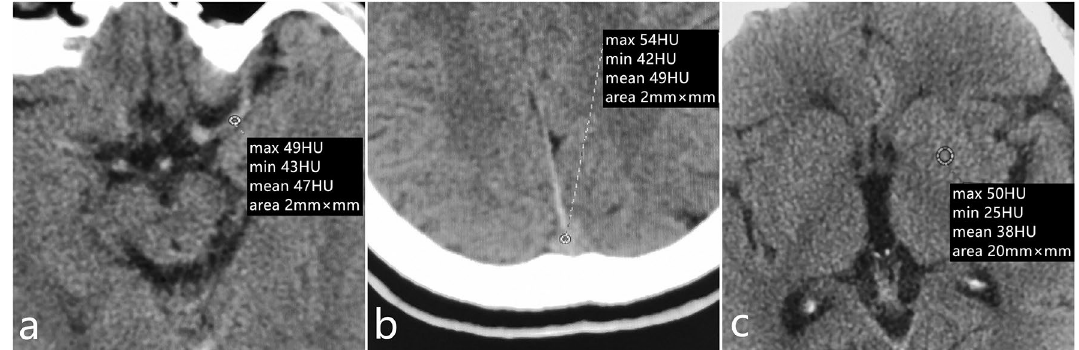
Figure 1. The CT values for basal ganglia, the middle cerebral artery, and the superior sagittal sinus were collected. The middle cerebral artery ( a ), the superior sagittal sinus ( b ), basal ganglia ( c